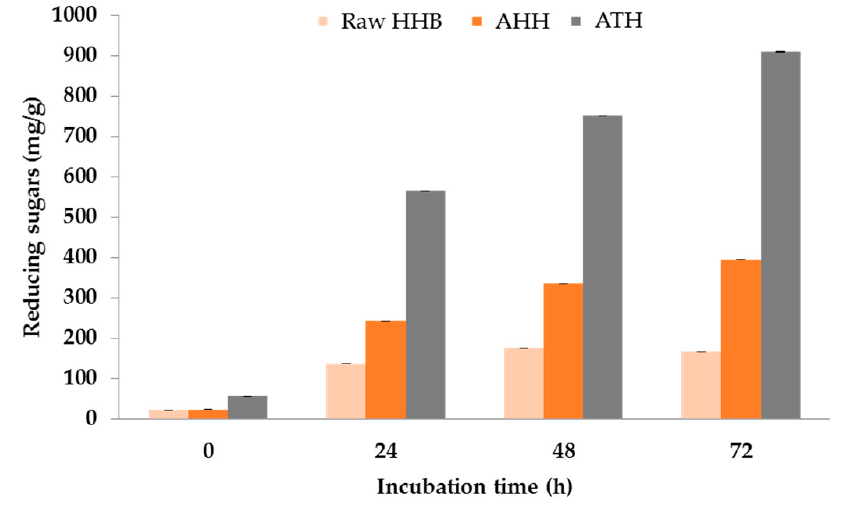
Figure 5. Enzyme saccharification of raw, AHH and ATH for 72 h using cellulase from Trichoderma reesei .